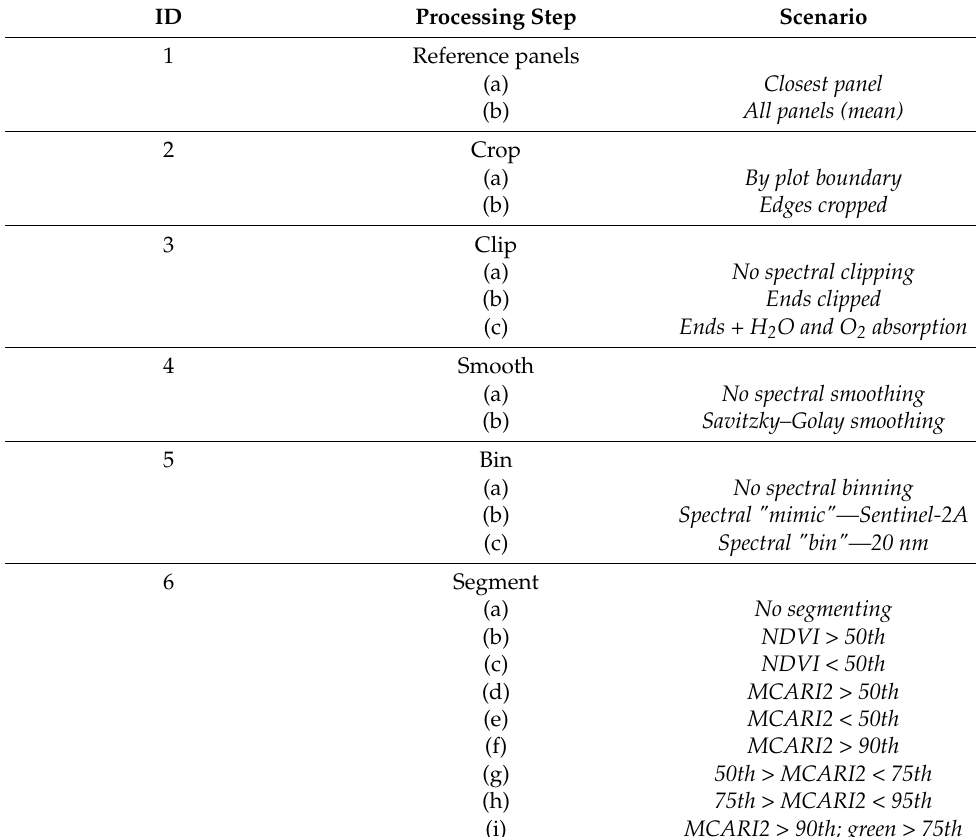
Table 1. Experimental image processing scenarios evaluated at each image processing step. The two spectral indices used in the segmentation step were the normalized difference vegetation index ( NDVI ) and the modified chlorophyll absorption ratio index improved ( MCARI2